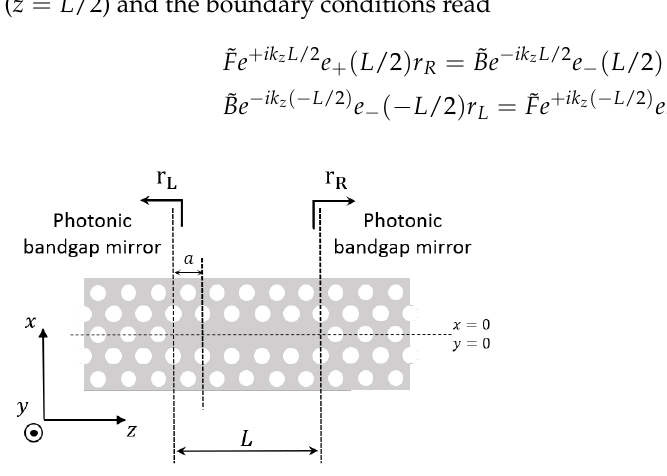
Figure 8. LN cavity, with N denoting the number of missing holes. The figure illustrates our choice of the reference planes for the cavity length L